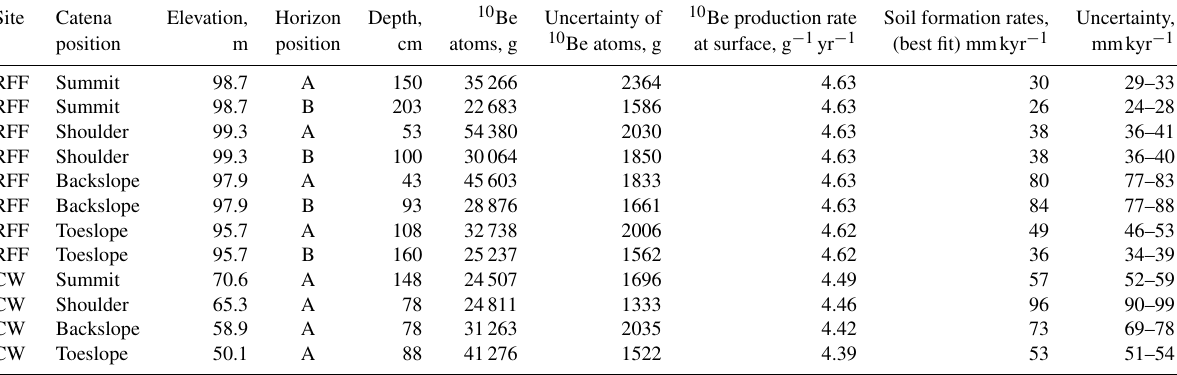
Horizon position A denotes the sample was taken at the soil–saprolite interface. Horizon position B denotes an additional sample was taken ∼ 50cm below the interface from the same depth profile. The depth here refers to that for the midpoint (between the top and bottom) of the sample. The shielding correction was calculated as 1.0 (to 1d.p., decimal point) for all samples, and 10 Be production rates are corrected for elevation and location (see Table S1 in the Supplement). All uncertainties are 1 standard deviation and are based on uncertainties in the measurement of 10 Be concentration as outlined in Rodés et al. (2011).